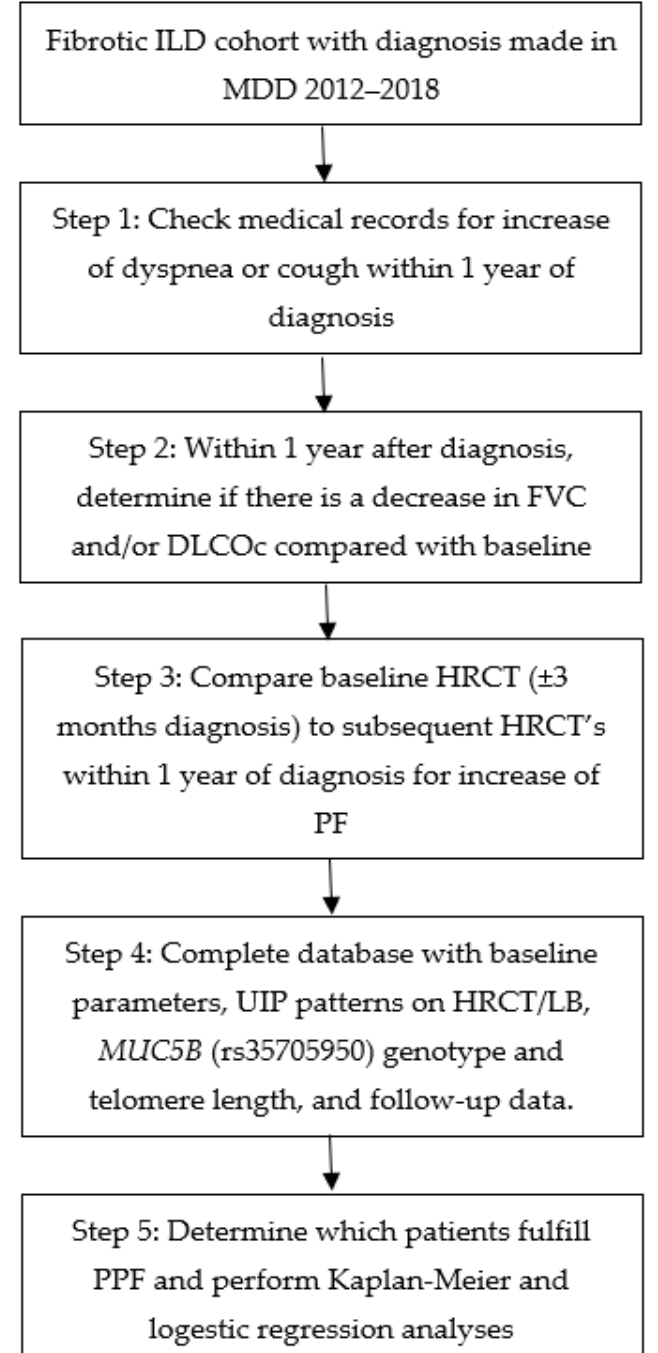
Figure 1. Step-by-step overview of the data collection process. DLCOc: Diffusing capacity for carbon monoxide corrected for hemoglobin, FVC: Forced vital capacity, HRCT: High-resolution computed tomography, LB: Lung biopsy, MDD: Multi-disciplinary discussion, PPF: Progressive pulmonary fibrosis and UIP: Usual interstitial pneumonia.